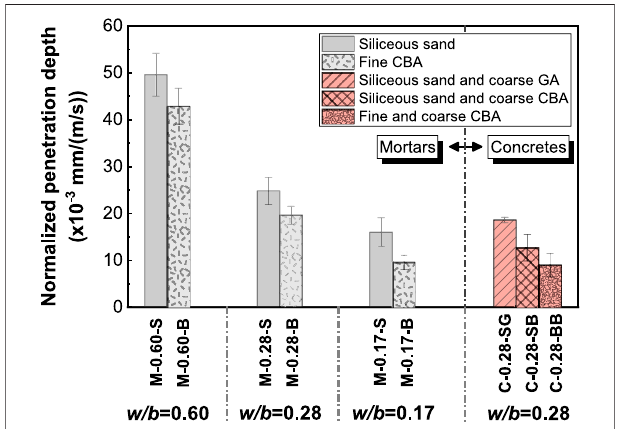
FIGURE 8 | Effect of CBA on the DOP of cement composites subjected to deformable copper HVPI.